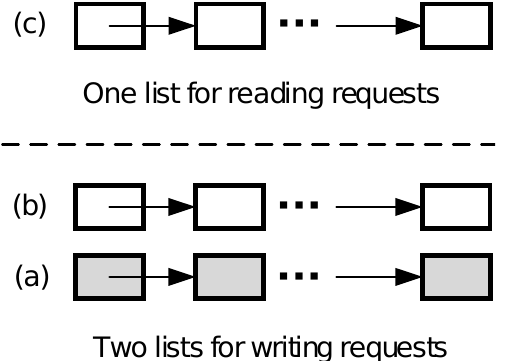
Figure 3. Two pairs of statically pinned memory block